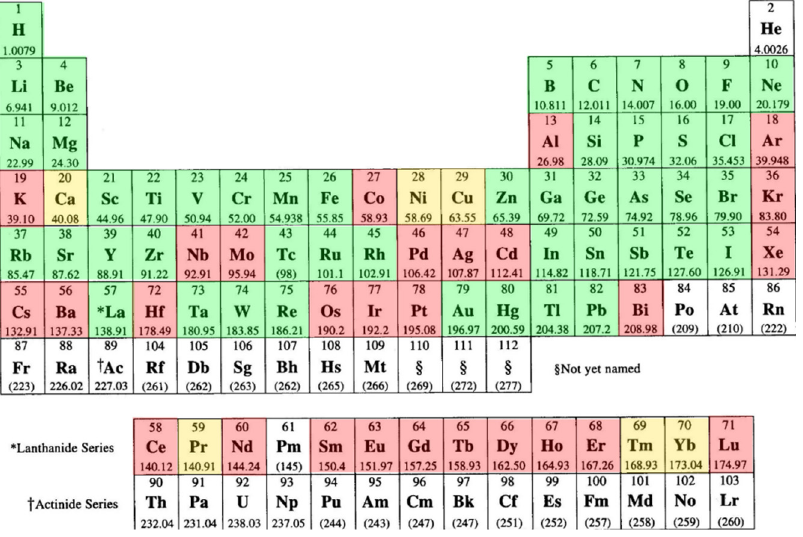
Figure 4. Periodic table of the elements with residual activity of the elements 100 years from the end of operation: green—less than 10 mSv/h; yellow—near 10 mSv/h; red—more than 10 mSv/h [33].